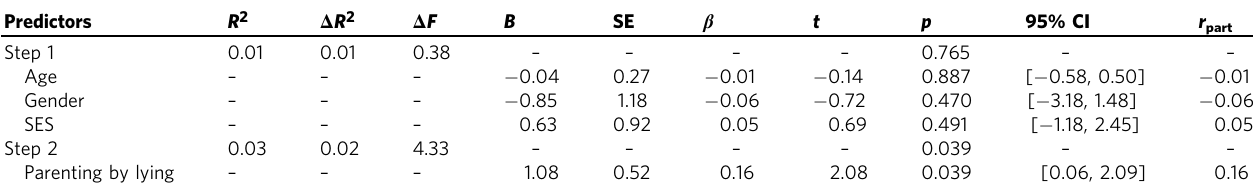
Table 1 Hierarchical regression for lying to parents as predicted by parenting by lying.